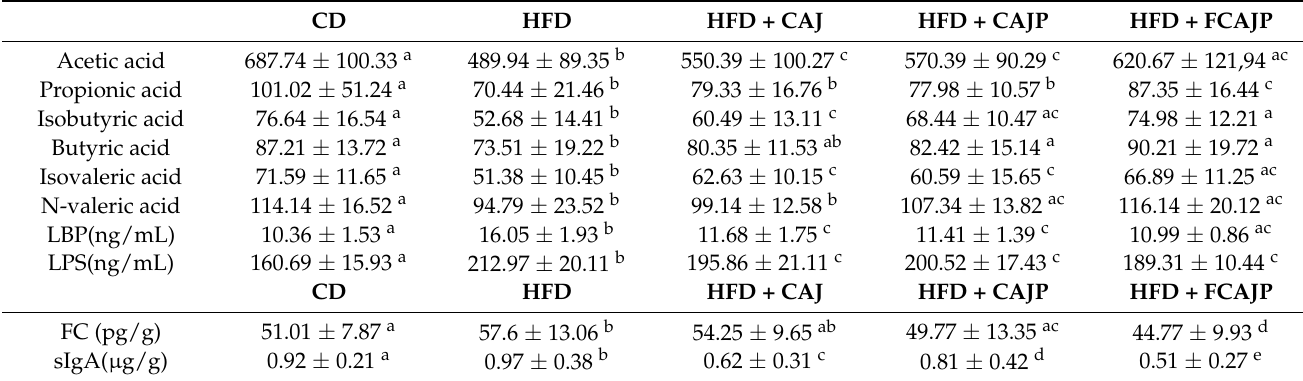
Effect of three cloudy apple juices on SCFAs concentrations ( µ g/g), intestinal permeability and intestinal